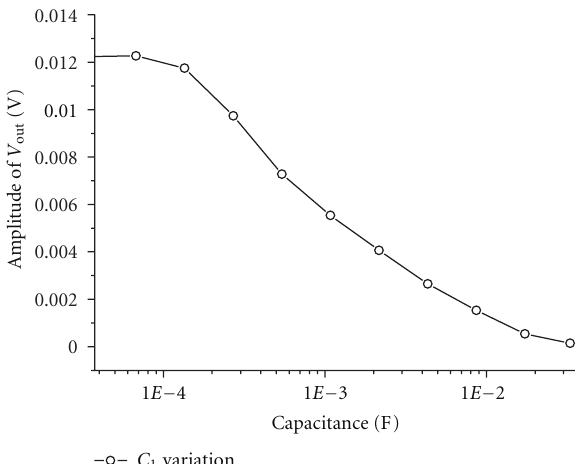
Figure 19: Response characteristic of the output voltage curve for the pulse parameter for a change of the capacitance C 1 (33 (nF) ∼ 33 (mF)).